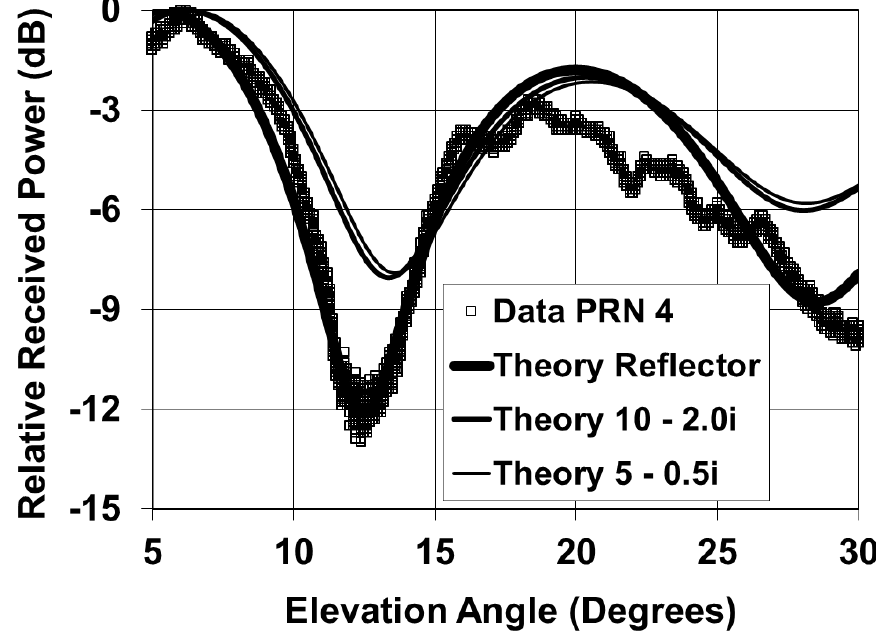
Figure 6. Theoretical elevation plot for the difference between a 6.8-cm-thick snow layer covering a ground reflector and a 6.8-cm-thick snow layer covering frozen soil with a composition of Field 5 with h = 45.1 cm. The values ε ε = 10 − i 2.0 are used in the soil5